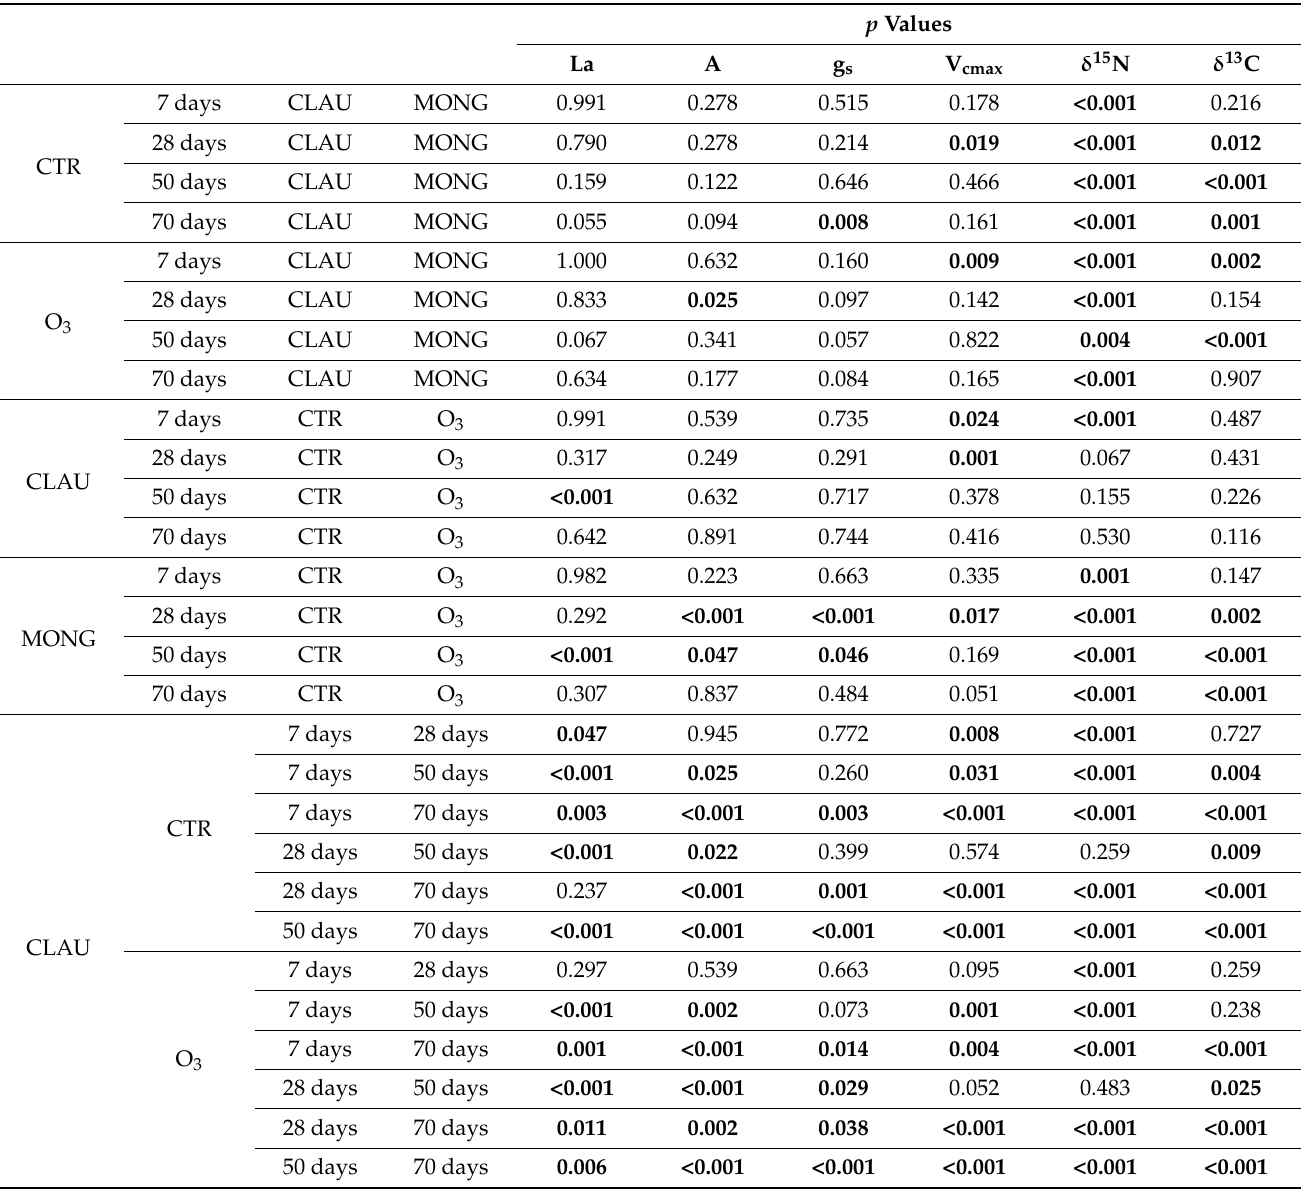
Table 3. Three-way ANOVA analysis describing significant differences among leaf area (La), CO 2 assimilation rate (A), stomatal conductance (g s ), maximum RuBP-saturated rate of carboxylation (V cmax ), δ 15 N and δ 13 C in durum wheat cultivars Claudio (CLAU) and Mongibello (MONG)